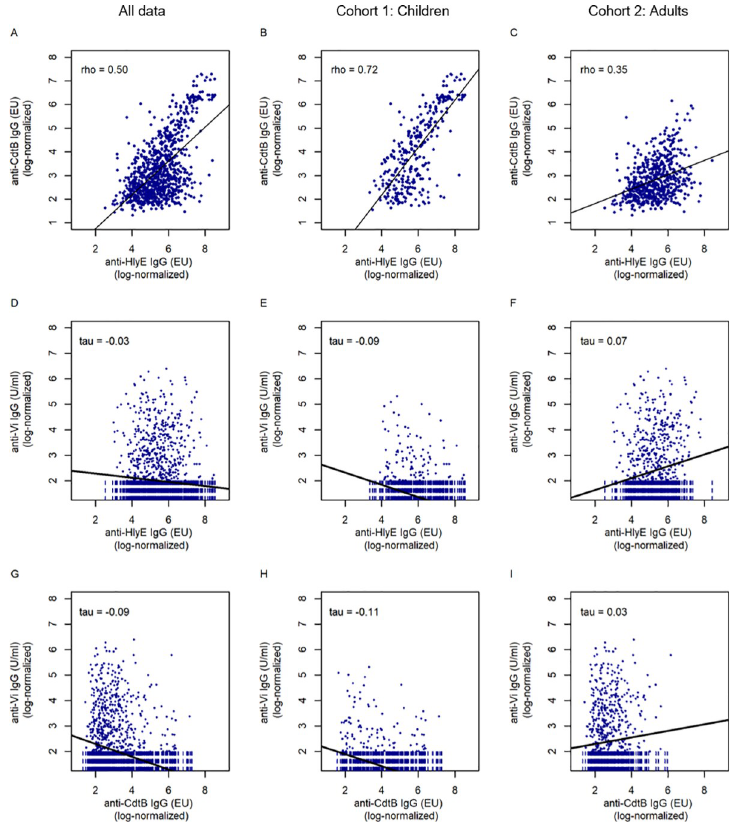
Fig 2. Correlation of anti– S . Typhi serum IgG titers against three antigens in children and adults in Lao PDR. A, B and C show the correlation between anti-HlyE IgG and anti-CdtB IgG for all data, cohort 1 and cohort 2 respectively. D, E and F show the correlation between anti-Vi IgG and anti-HlyE IgG for all data, cohort 1 and cohort 2 respectively. G, H and I show the correlation between anti-Vi IgG and anti-CdtB IgG for all data, cohort 1 and cohort 2 respectively. Black lines indicate predicted values from linear regression analysis in A, B and C and from Akritas-Thiel- Sen regression lines in D, E, F, G, H and I. Censored observations in D, E, F, G, H and I were plotted as vertical dashed